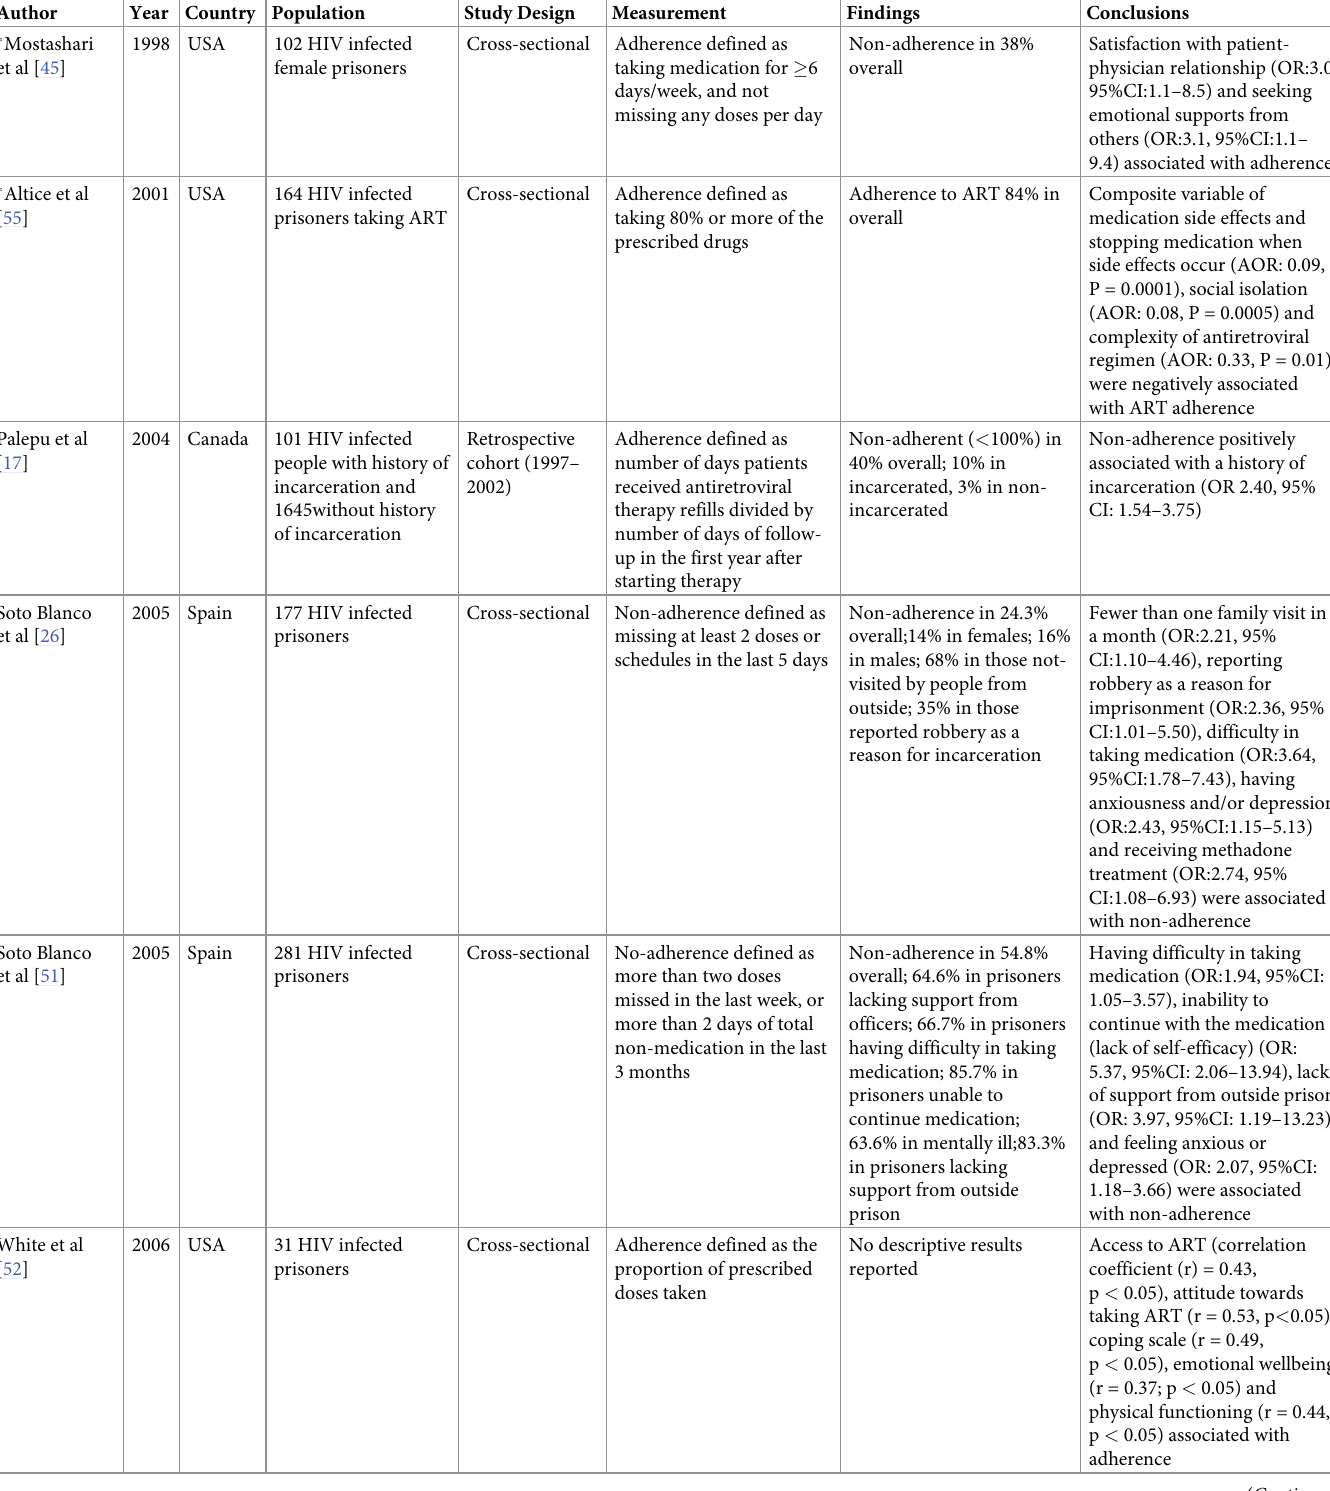
Table 2. Characteristics of studies investigating adherence to antiretroviral